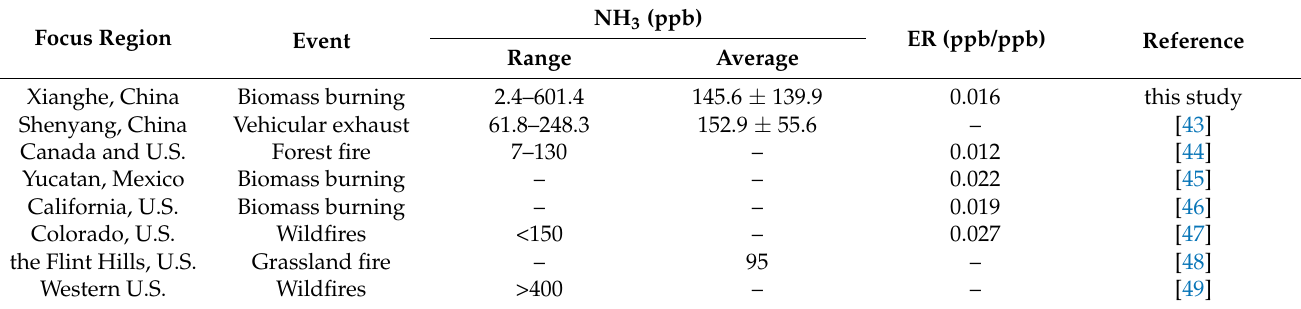
Table 2. Summary of the NH 3 concentration and its emission ratio (ER = ∆ NH 3 / ∆ CO) in different burn